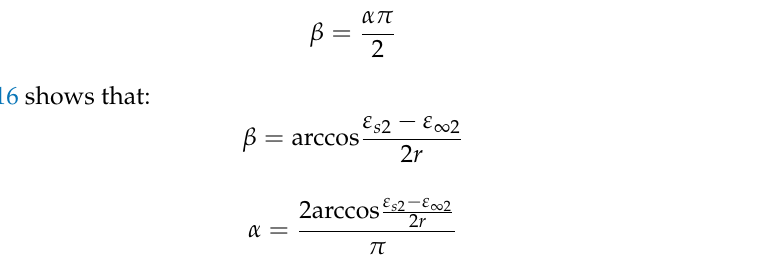
Figure 16. Cole-Cole diagrams in the low permittivity area ε (cid:48) for the composite of cellulose, trans- former oil and water nanoparticles and the circle describing the relation ε (cid:48)(cid:48) = f ( ε (cid:48) ). For the Cole-Cole relaxation, the angle β (Figure 16) between the ε (cid:48) axis and the radius of the circle at ε ∞ , expressed in radians, is related to the value α entered in Formula (12)